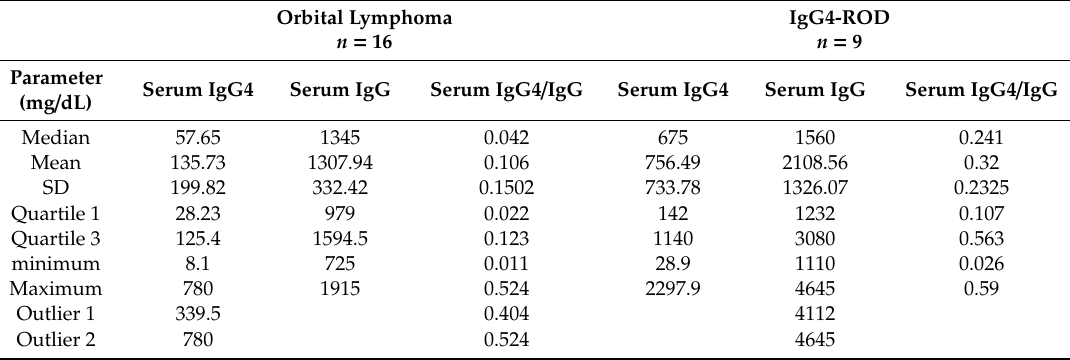
Table 4. The descriptive statistical prebiopsy values of serum IgG4 levels (serum IgG4), serum immunoglobulin G (IgG) levels (serum IgG) and the ratios of serum IgG4 level / serum IgG level (serum IgG4 / IgG) of the 16 patients with orbital lymphoma and the 9 patients with